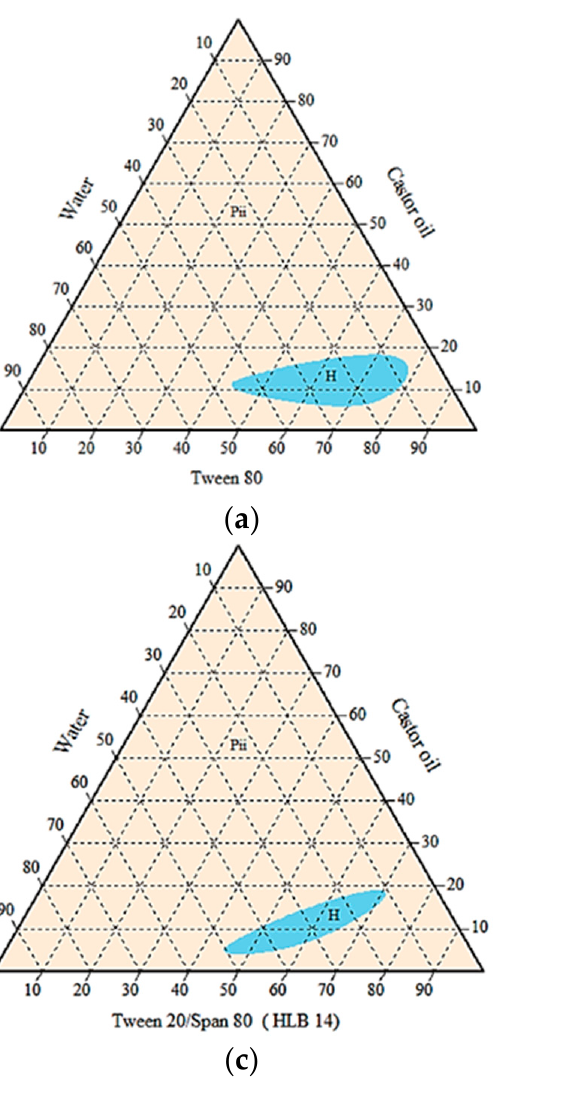
Figure 3. Pseudo-ternary phase diagrams of castor oil/surfactant/water systems without active in- gredients, using single or mixed surfactants ( a ) Tween 80, ( b ) Tween 20, ( c ) Tween 20:Span 80, and ( d ) Tween 80:Span 80. H = homogenous cloudy or milky; P ii = multiphase.